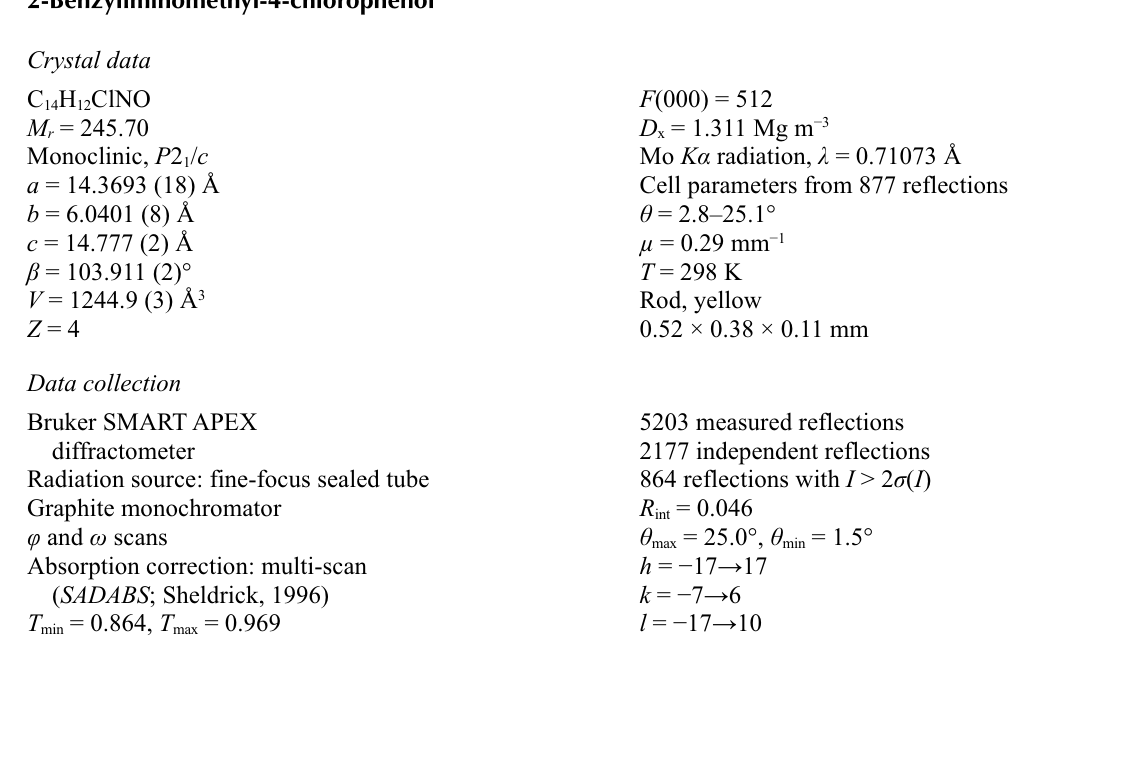
Figure 2 Packing of the molecules viewed along the b axis.